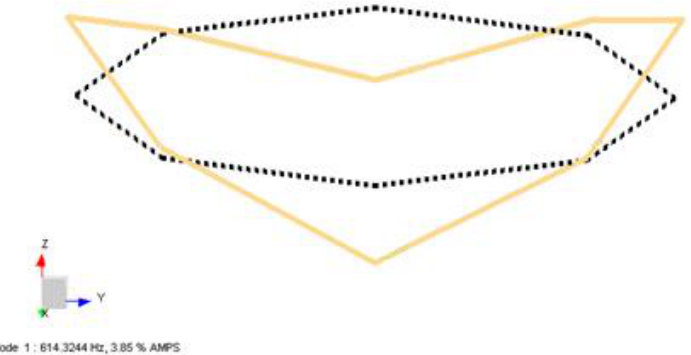
Figure 14. First mode shape obtained from LMS Test Lab software for the Type-2 coil sample.